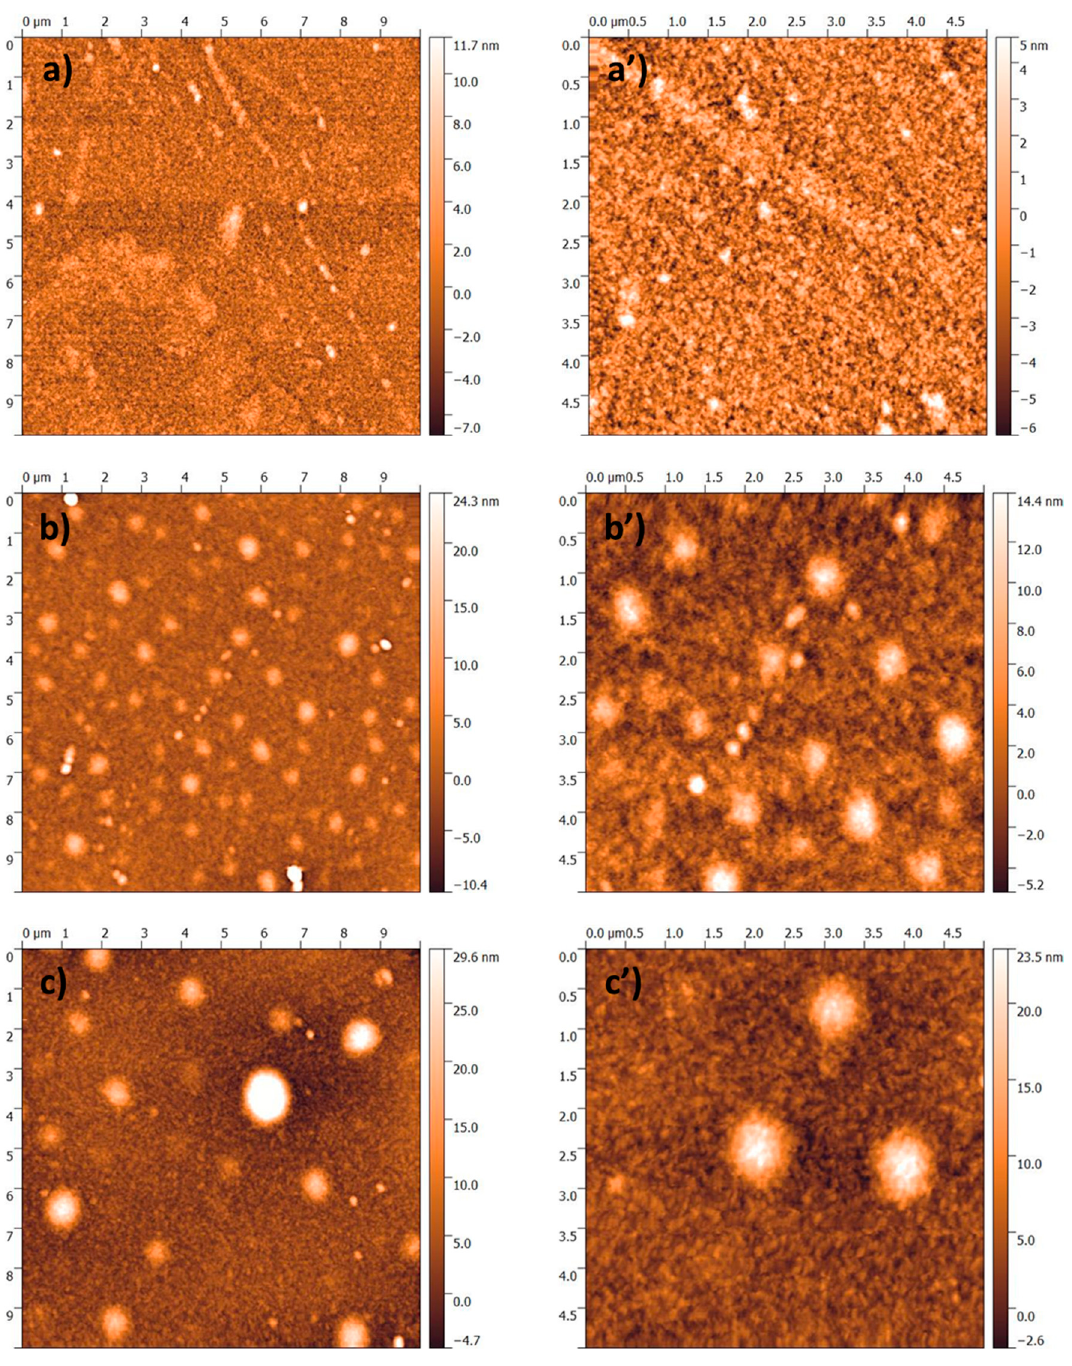
Figure 2. Atomic force microscopy (AFM) micrographs of ZnO-CF x nanocomposites having an inorganic phase volume fraction of φ = 0.05 ( a – a’ ), φ = 0.10 ( b – b’ ), and φ = 0.15 ( c – c’ ).